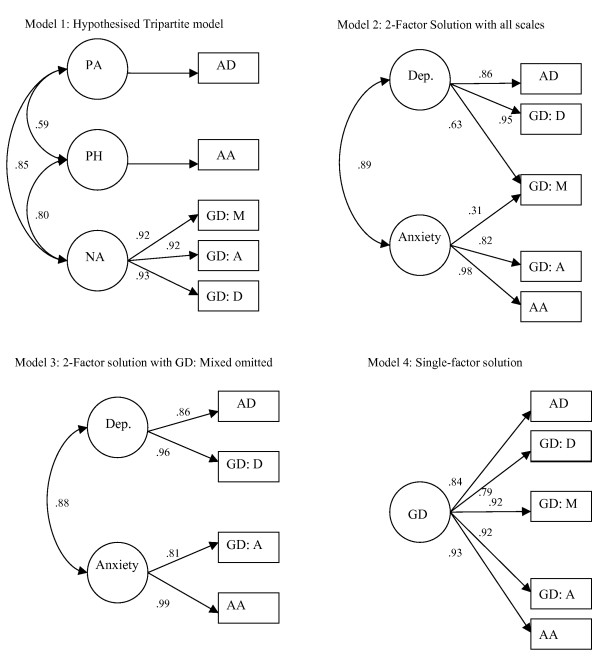
Models tested in the current analyses.